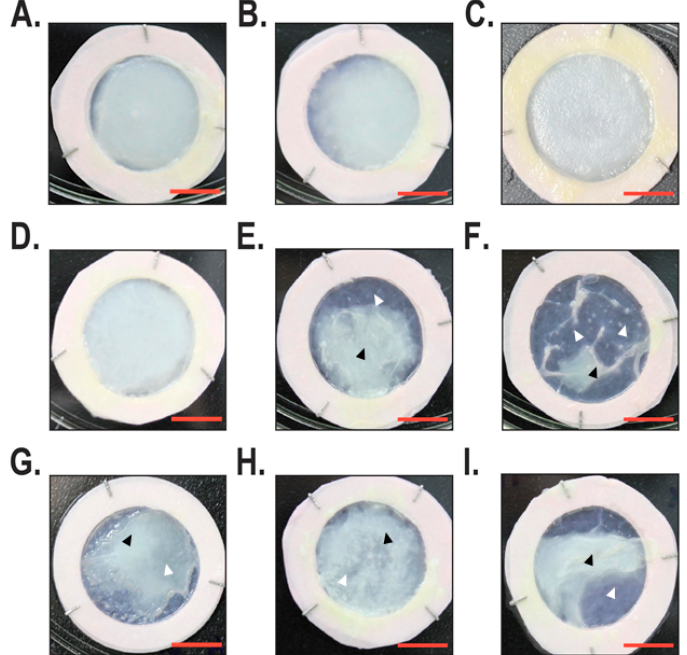
Figure 1. Macroscopic analysis of the reconstructed skin substitutes. For each group, tissue- engineered skin substitutes were produced with three different cell populations. ( A – C ) Tissue- engineered skin substitutes produced with healthy fibroblasts and keratinocytes. ( D –I) Tissue- engineered skin substitutes produced with fibroblasts and keratinocytes isolated from either non- lesional ( D – F ) or lesional ( G – I ) psoriatic skin. Scale bar = 1 cm. Black arrowheads indicate the position of protuberant regions, whereas white arrowheads position thinner regions of the reconstructed skin substitutes.